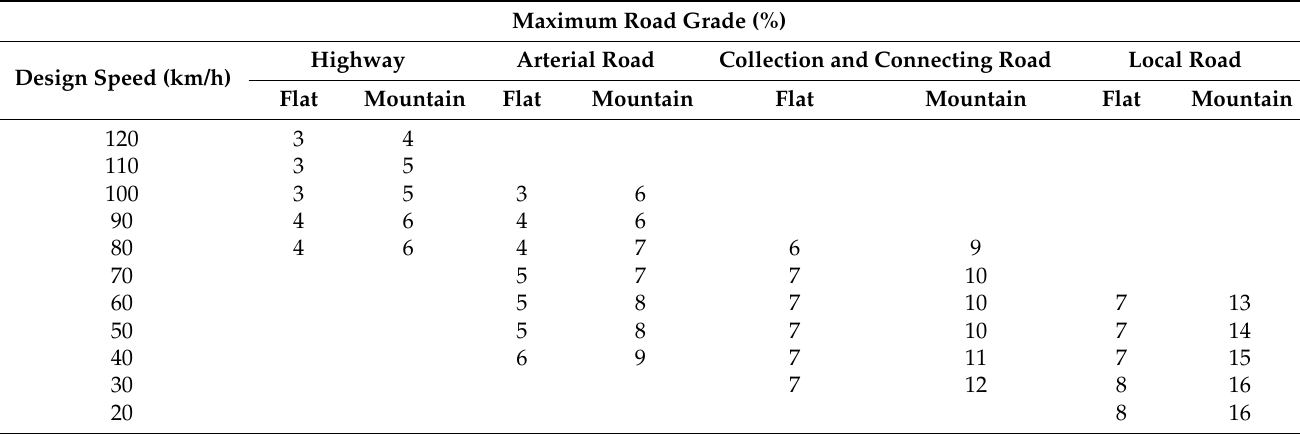
Table 2. Maximum road gradients according to Korean Road